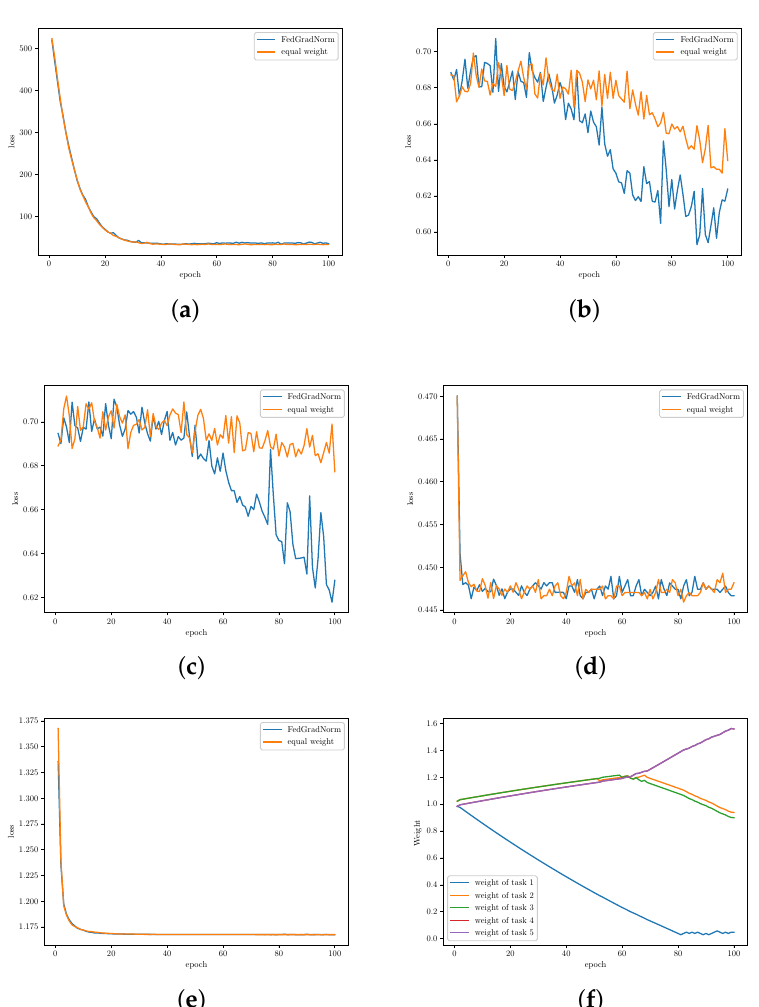
Figure 3. Comparison of task losses in FedGradNorm and FedRep ; balanced data allocation among tasks ( a ) task 1 (face landmark), ( b ) task 2 (gender), ( c ) task 3 (smile), ( d ) task 4 (glasses), ( e ) task 5 (pose), ( f ) task weights.